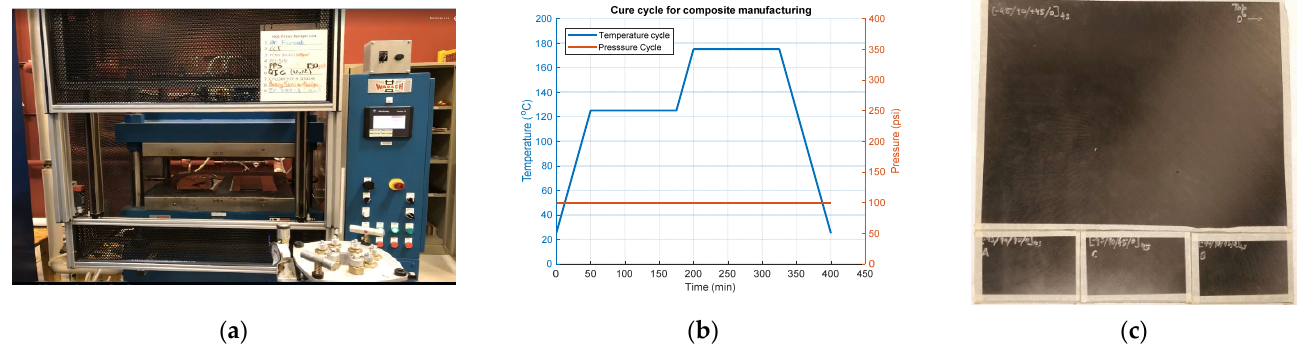
Figure 3. Manufacturing of composite coupons for impact testing: ( a ) Wabash hot press machine; ( b ) Manufacturing cure-cycle; ( c ) Cured composite laminate with 6” × 4” cut-outs.